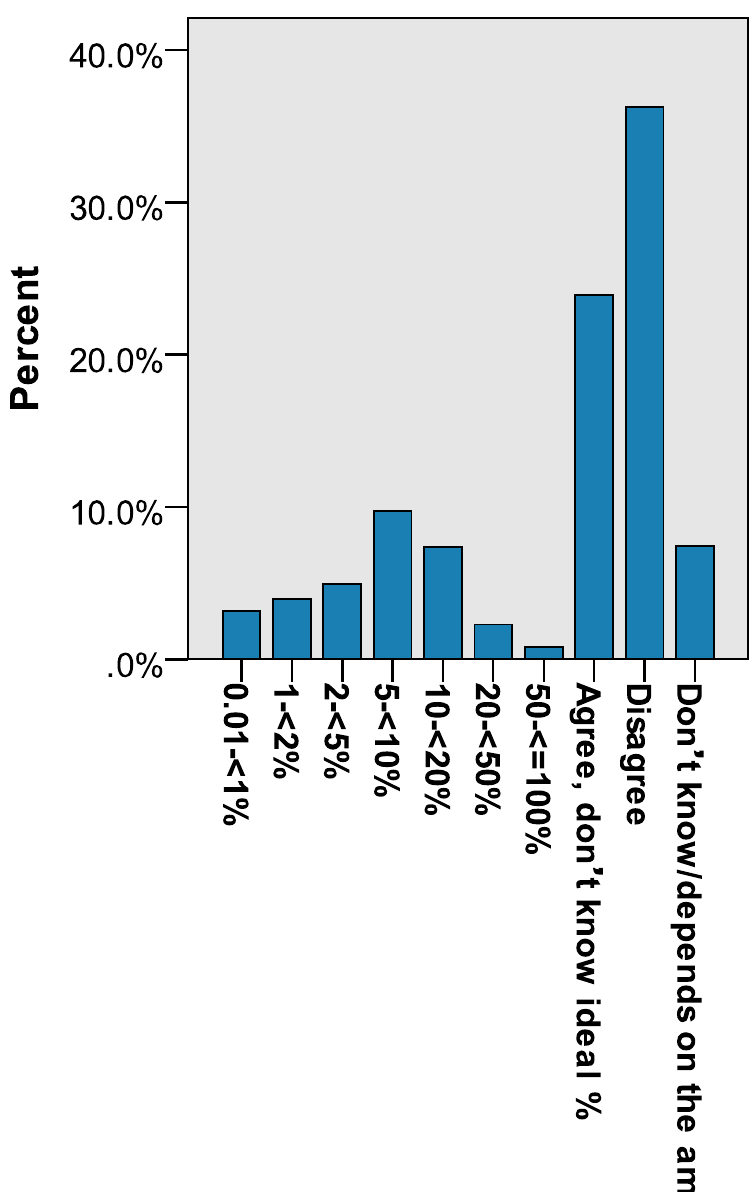
Fig 1. Percent of n = 925 respondents’ answers to: Do you agree or disagree that some government budget should be allocated to the Disaster Relief Fund? If yes, what would be the ideal percentage?